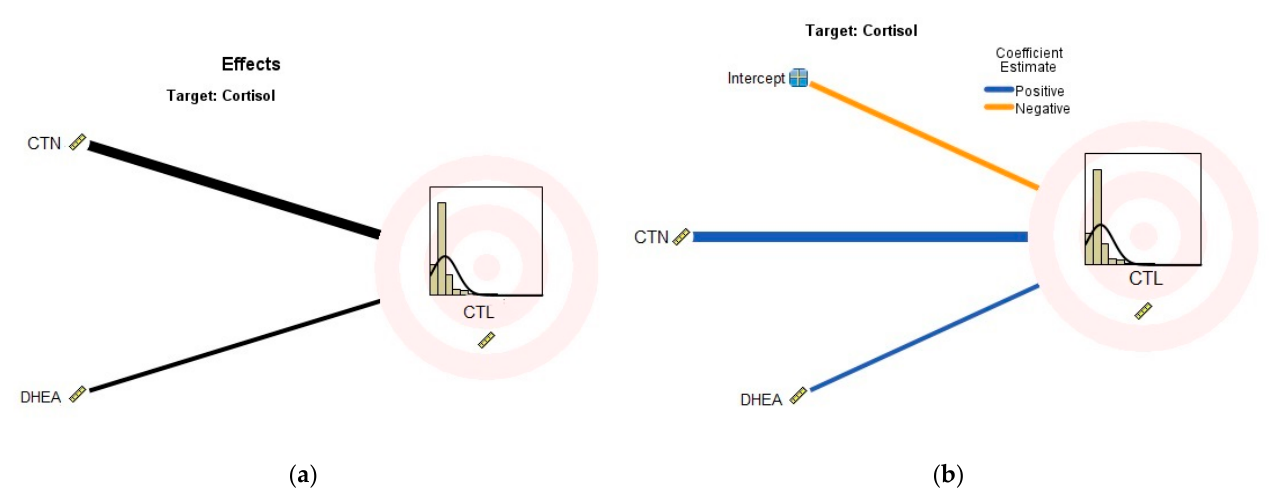
Figure A1. The forward stepwise model selection method results presented for Model 1 after automatic linear modelling: ( a ) the identified effects of the predictors on cortisol levels (CTL) by cortisone (CTN) and dehydroepiandrosterone (DHEA) and ( b ) the negative and positive coefficient estimations that were identified for cortisone (CTN) and dehydroepiandrosterone (DHEA) in Model 1.